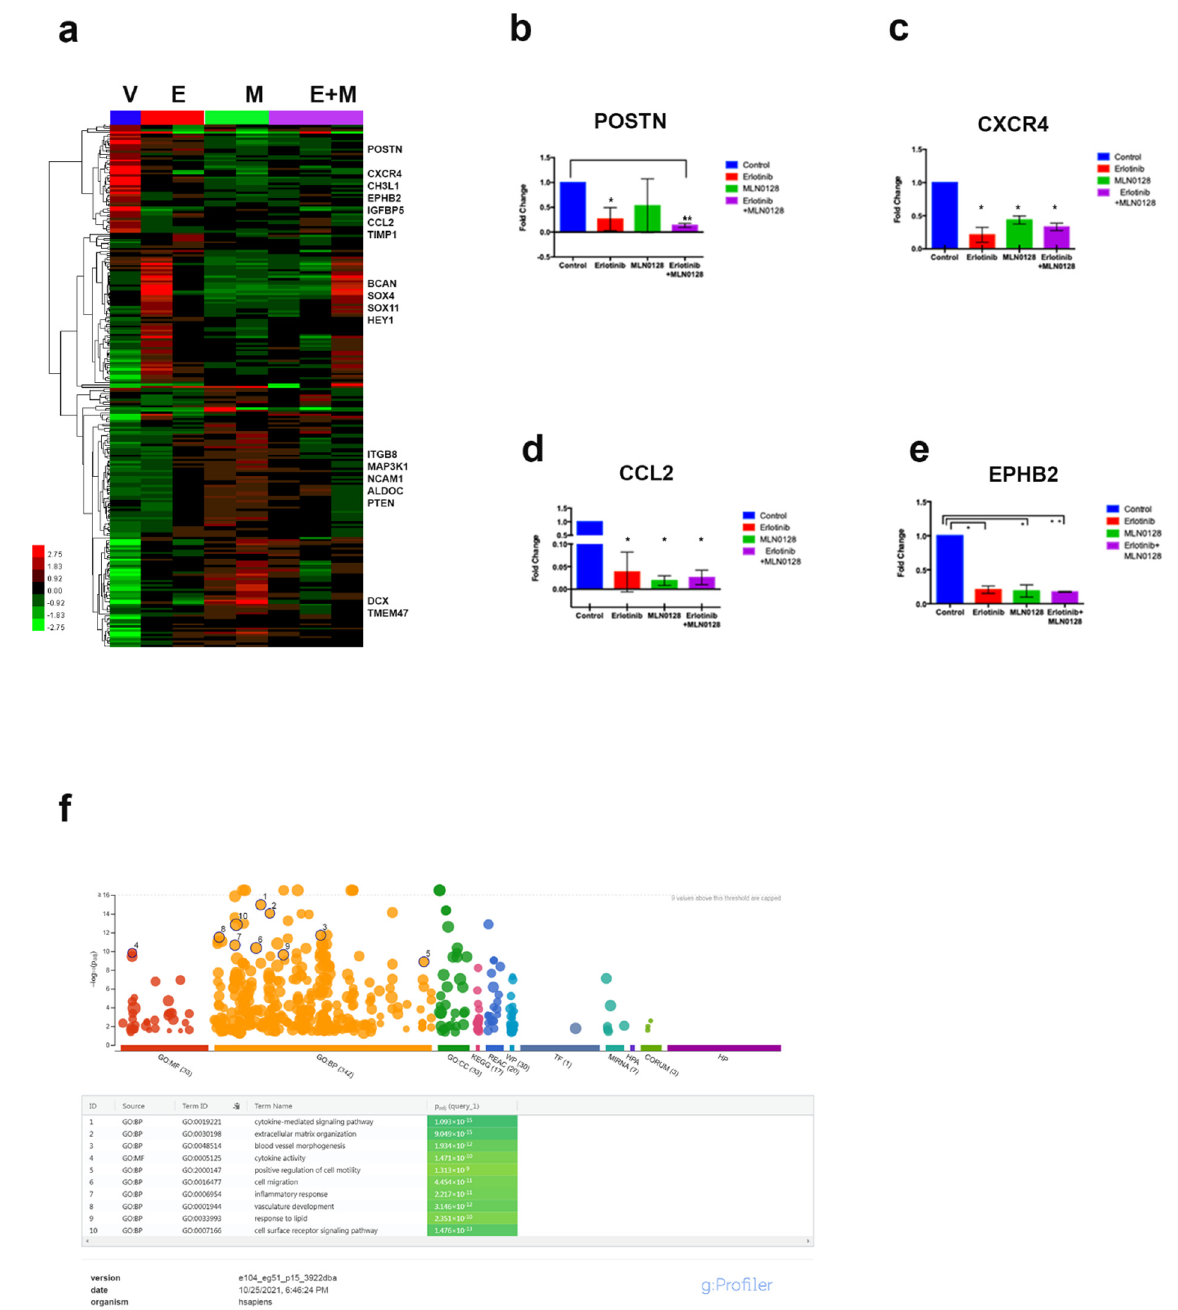
Figure 4. Transcriptomic profiling of GBM192 PDX treated with erlotinib and MLN0128. ( a ) Heatmap showing differentially expressed genes in the vehicle (V), erlotinib (E), MLN018 (M), and combination (E+M) treated tumors. A subset of 200 up- and down-regulated genes (>1.5 fold change; adjusted p < 0.05) are shown. On the right side of the heatmap, representative gene names are indicated for each cluster. ( b – e ) Taqman validation of microarray data; fold change in expression levels for four genes (POSTN, CXCR4, CCL2, and EphB2) in each treatment group are shown. Statistical analysis was performed using t -test. ( b ) * p < 0.05; ** p < 0.0001, compared to vehicle. ( c , d ) * p < 0.02 for all treatment arms compared to vehicle. ( e ) * p < 0.02; ** p < 0.0001 compared to vehicle. ( f ) GO pathways were significantly impacted by the combination of erlotinib+MLN0128 treatment in vivo. The diagram was obtained using the open-source g-Profiler